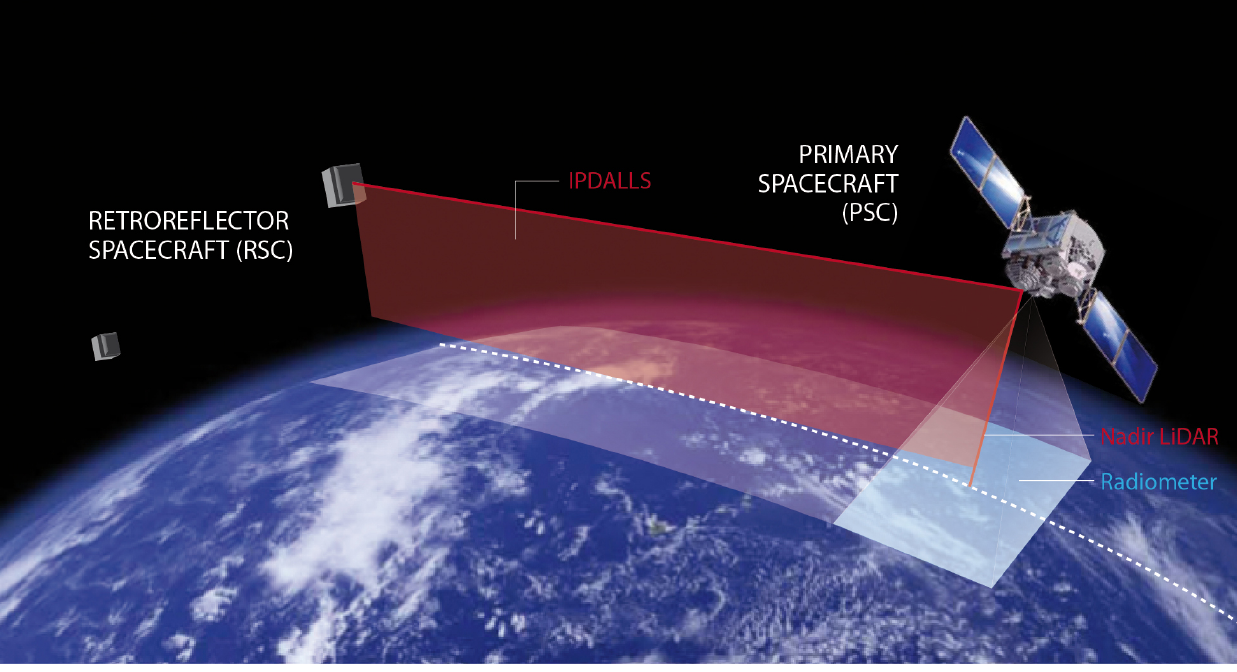
Figure 1. Illustration of the mission concept. The primary spacecraft is flown in an orbit which is counter-rotating with respect to a constellation of retroreflectors. The primary spacecraft carries a water vapour Differential Absorption LiDAR in nadir-viewing mode, and a monostatic IPDA LiDAR for limb sounding by occultation geometry (IPDALLS), using the retroreflectors as hard targets. The primary spacecraft also carries an imaging radiometer optimised for wider-swath cloud and aerosol